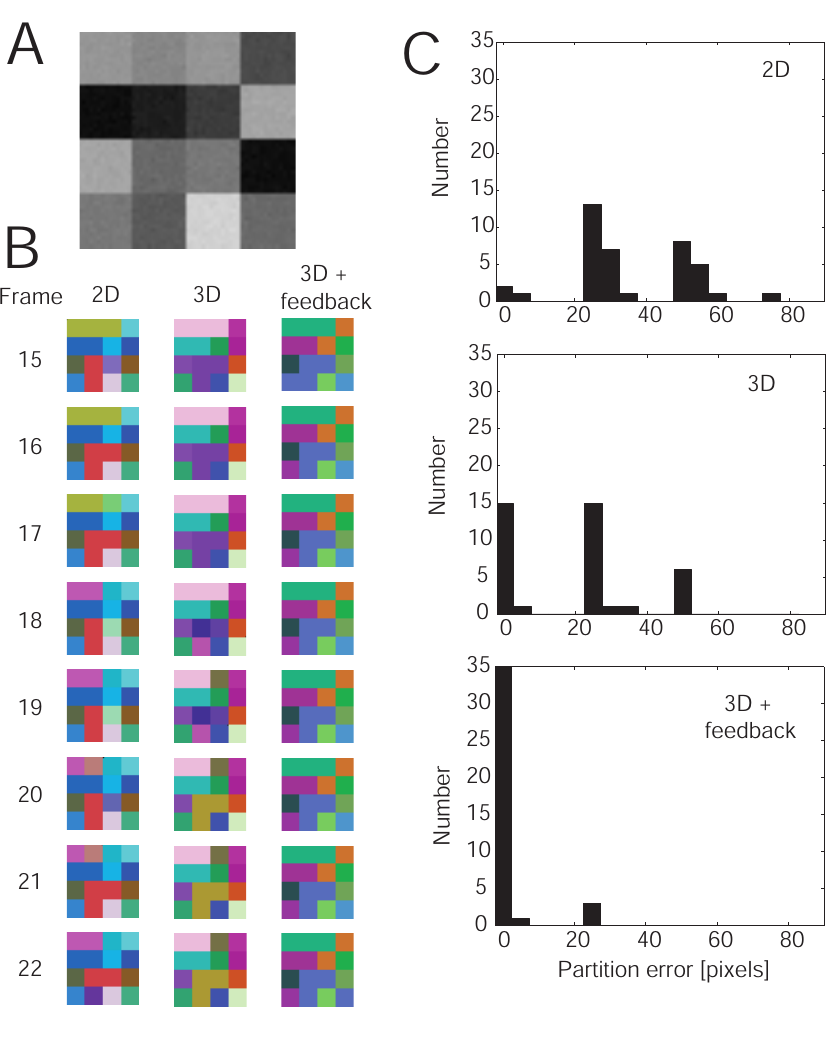
Figure 8. Improving partitioning consistency using 3D linking and feedback control.